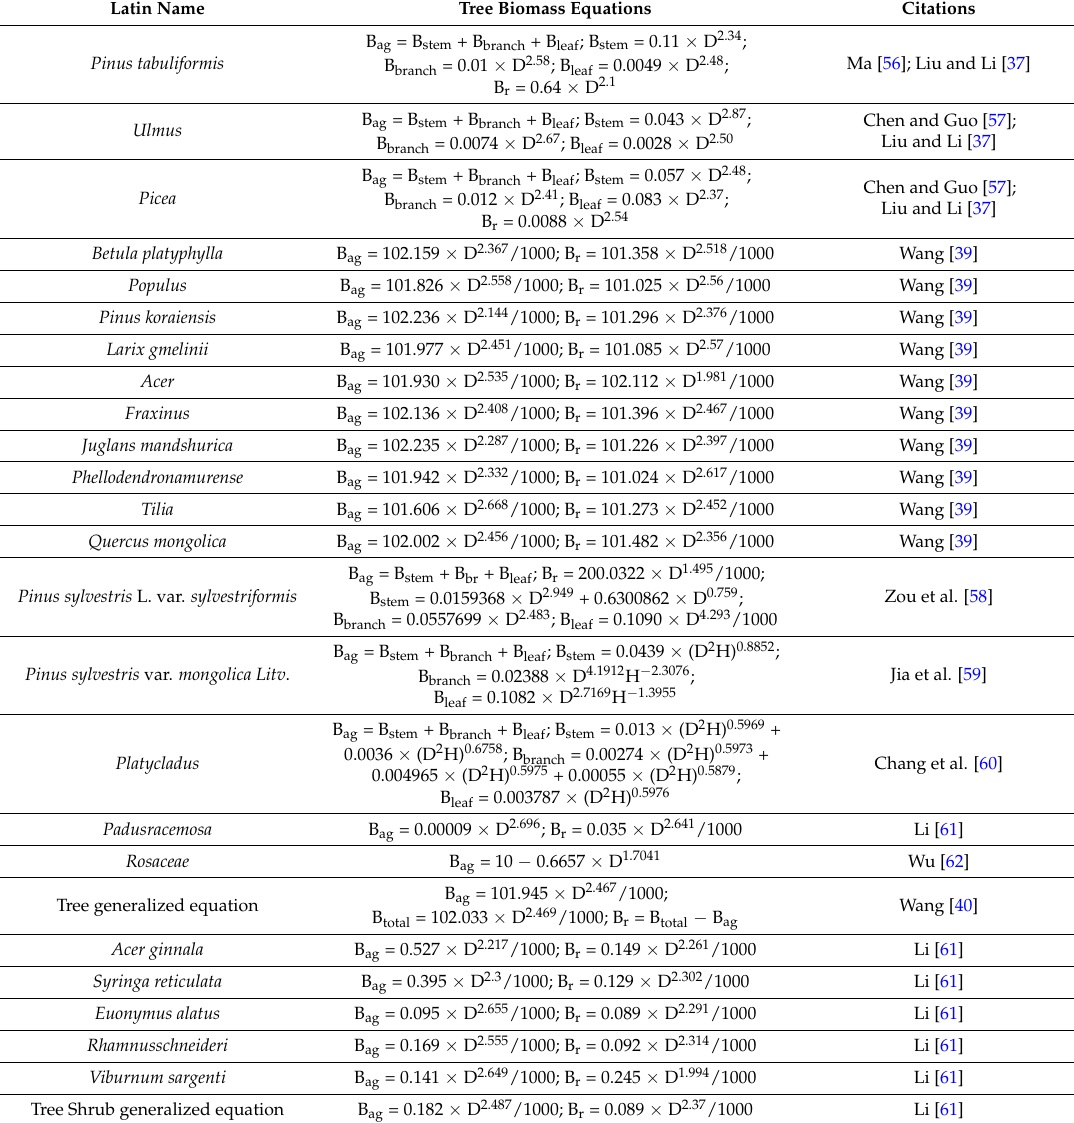
Table A1. Allometric relations used in this paper.